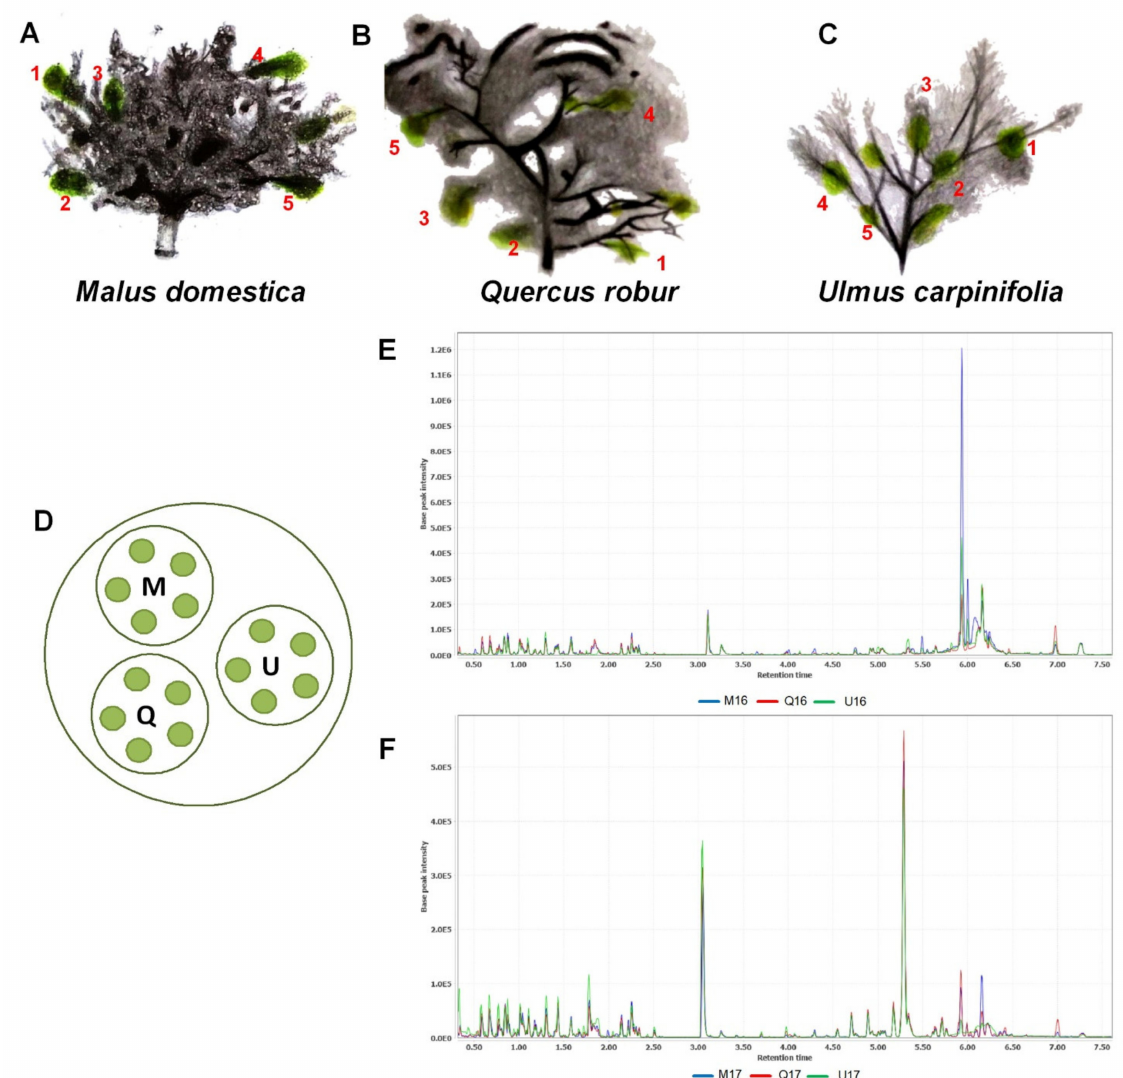
Figure 1. Five independent biological replicates from V. album ssp. album (1–5 in red) from the following different host trees: ( A ) Malus domestica , ( B ) Quercus robur and ( C ) Ulmus carpinifolia . ( D ) Harvest pattern of the V. album samples. Base peak chromatograms of the UHPLC-Q-TOF analysis conducted in 2016 ( E ) and 2017 ( F ). The codes represent the different host trees analyzed as follows: M ( M. domestica ); Q ( Q. robur ); U ( U. carpinifolia